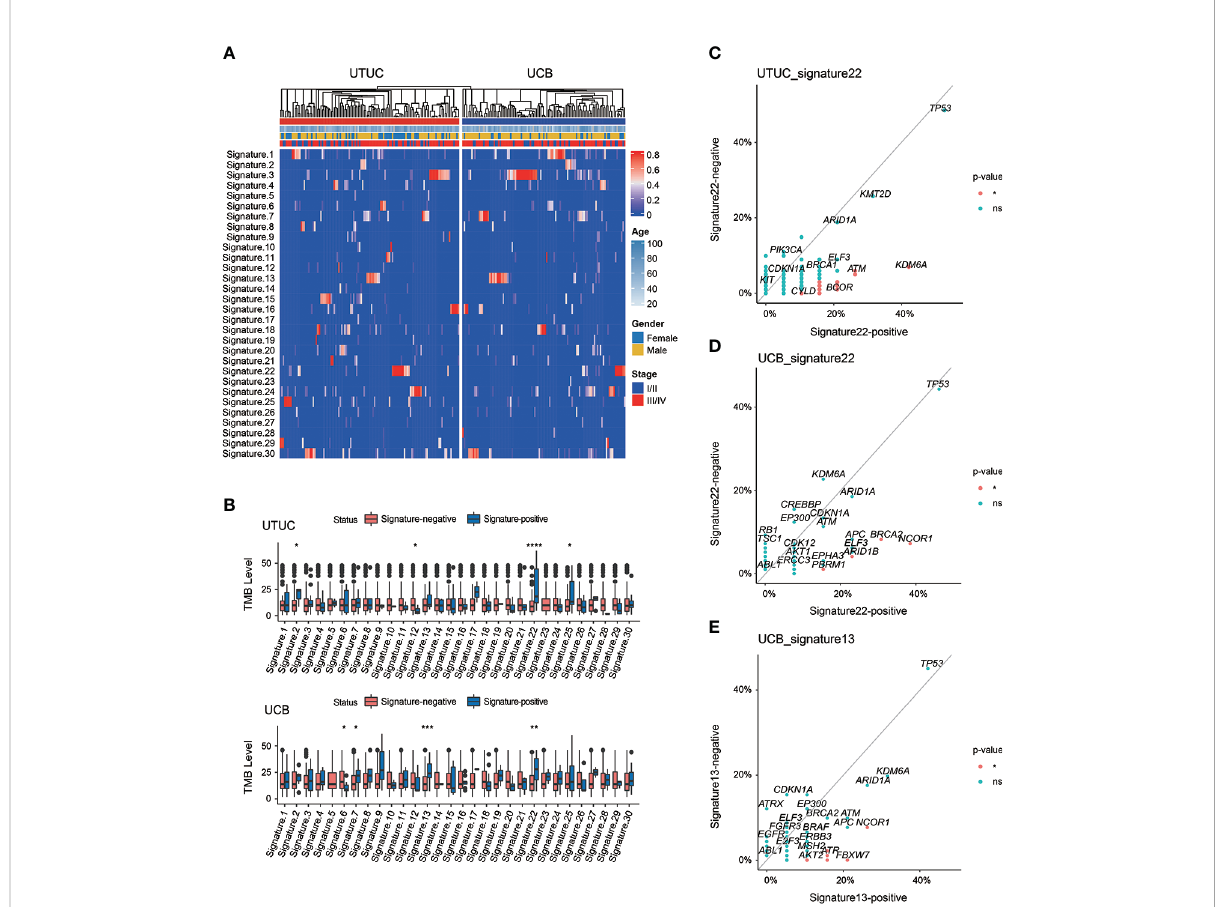
FIGURE 7 Spectrum of mutational signatures in Chinese UTUC and UCB. (A) Comparison of mutational signatures between Chinese UTUC and UCB. (B) Comparison of the TMB levels between patients with or without one extent mutational signature, respectively in UTUC and UCB. (C) Enrichment of GAs for UTUC patients with or without mutational signature 22. (D) Enrichment of GAs for UCB patients with or without mutational signature 22. (E) Enrichment of GAs for UCB patients with or without mutational signature 13. *: p < 0.05; **: p < 0.01; ****: p < 0.001; ***: p < 0.0001. ns, not signi fi